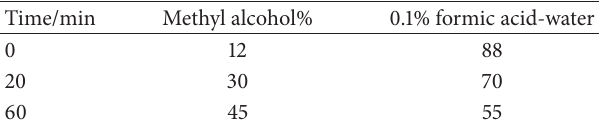
Table 1: Elution gradient